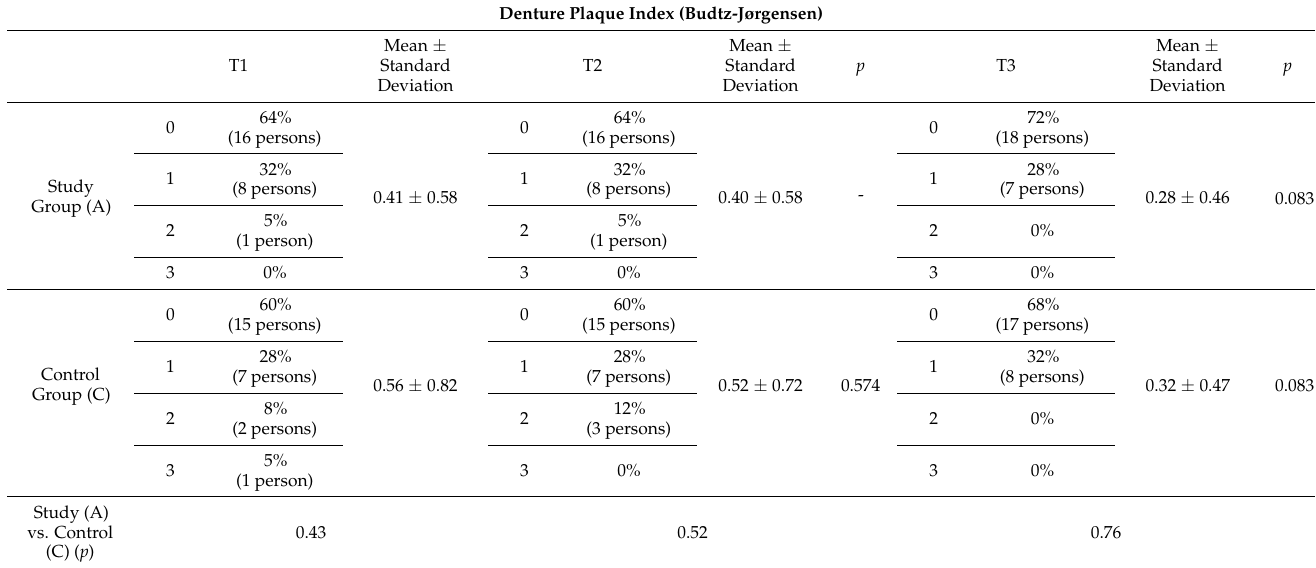
Table 3. Denture plaque index (DPI) ranges—assessment for study and control